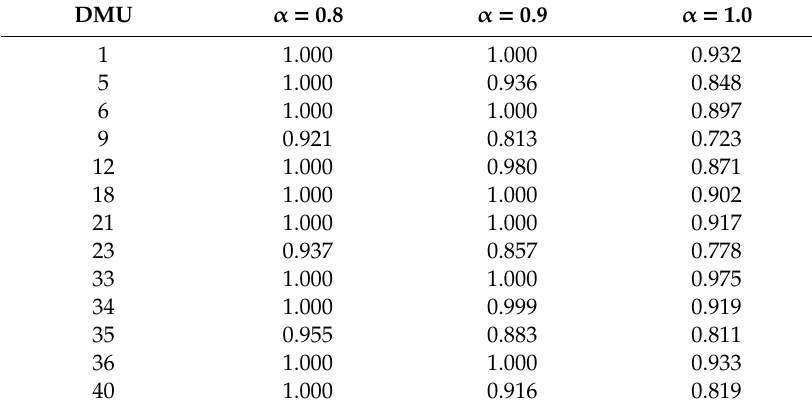
Table 5. Upper e ffi ciency estimates of Kao and Liu [20] for dataset 2 (The value is 1.000 for all DMUs and all α values not shown in the table). DMU α = 0.8 α =